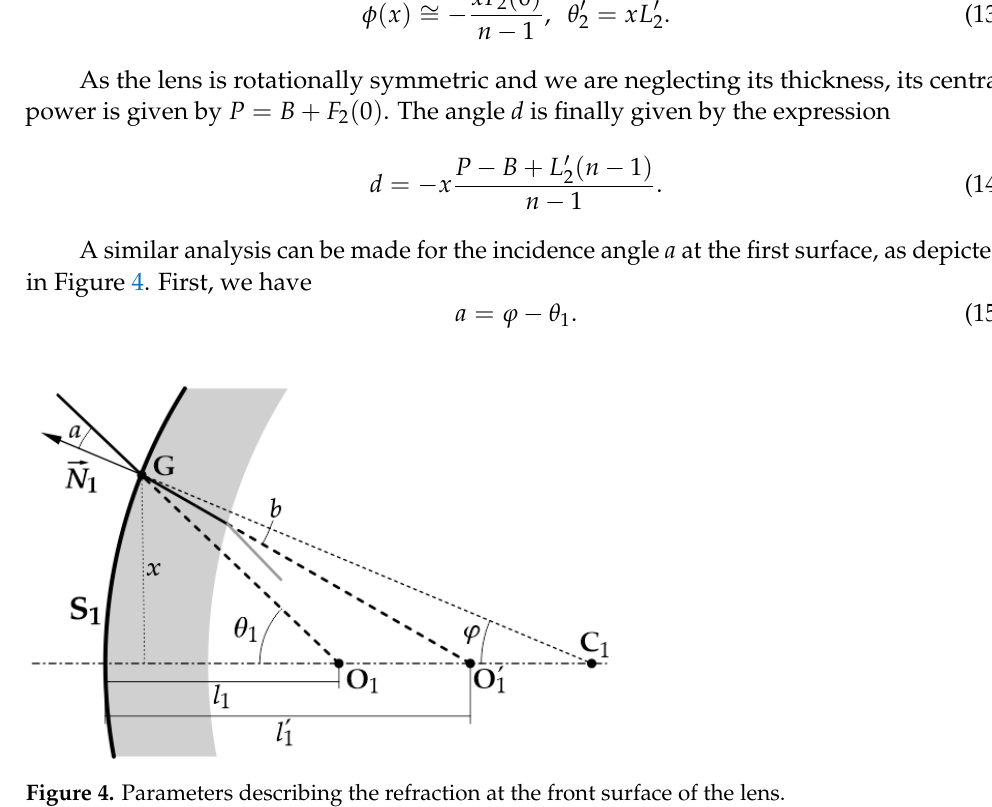
Figure 4. Parameters describing the refraction at the front surface of the lens.